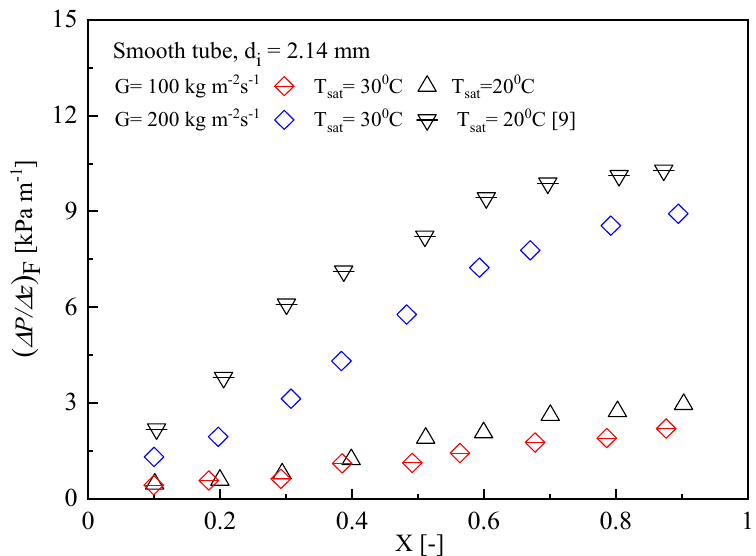
Figure 6. Effect of saturation temperature on frictional pressure drop.